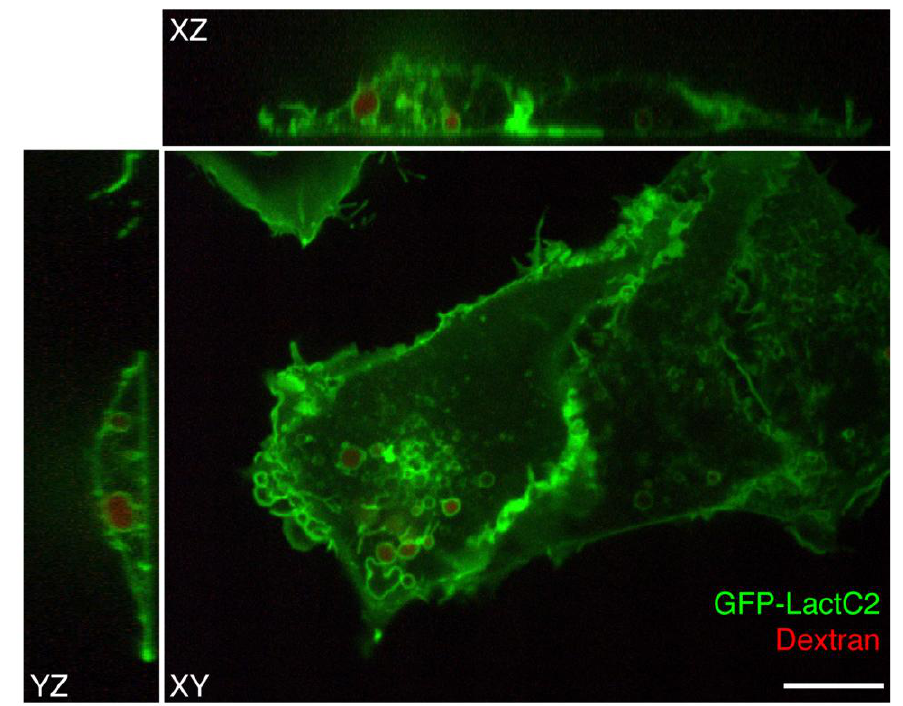
Figure 2. Distribution of GFP-LactC2, a PS-specific probe, in mammalian cells. COS-7 cells expressing GFP-LactC2 were pulsed with rhodamine-conjugated dextran followed by a 15 minute chase and were imaged live with confocal microscopy. The GFP-LactC2 probe (green) labels the plasma membrane as well as a number of internal membranes, including those positive for the fluid-phase endocytic marker, dextran (red). Bar = 10